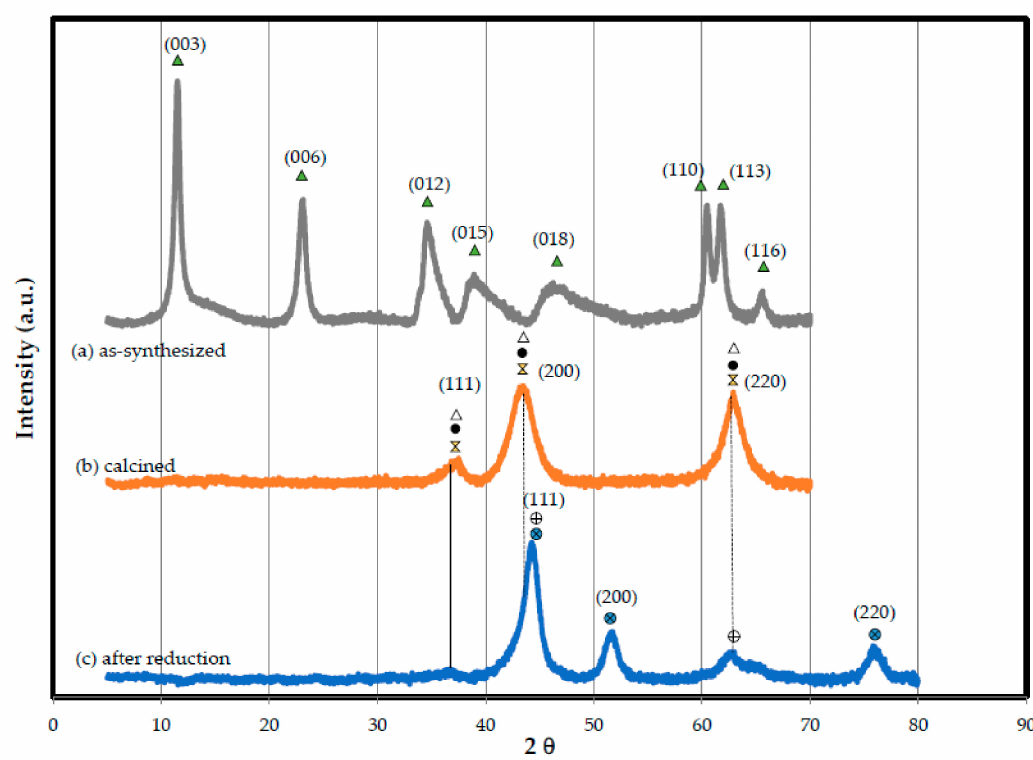
Figure 6. Ni-Fe-Cu/LDH XRD profiles ( a ) as-synthesized, ( b ) calcined, and ( c ) after reduction: ( ) hydrotalcite, ( ) MgO-like phase, ( • ) NiO, ( ) Ni(Fe)Ox, ( ) Ni metal, ( ) Ni–Fe